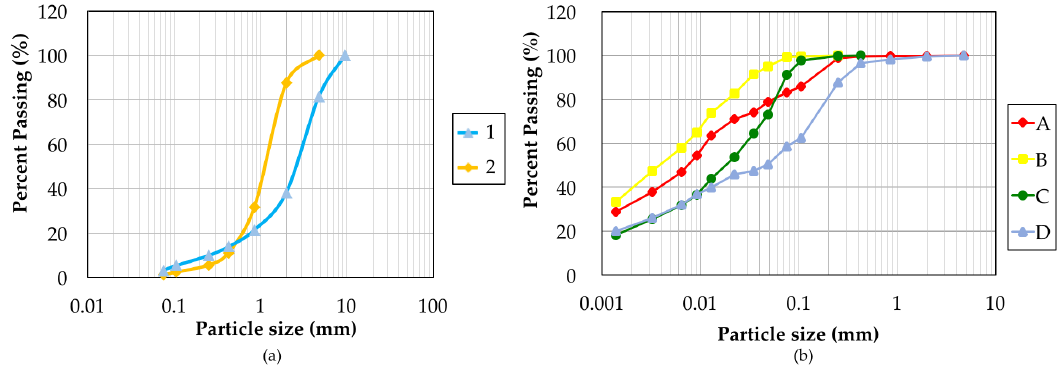
Figure 1. Particle size distribution of ( a ) steel slags and ( b ) dredged soils of fraction smaller than 4.75